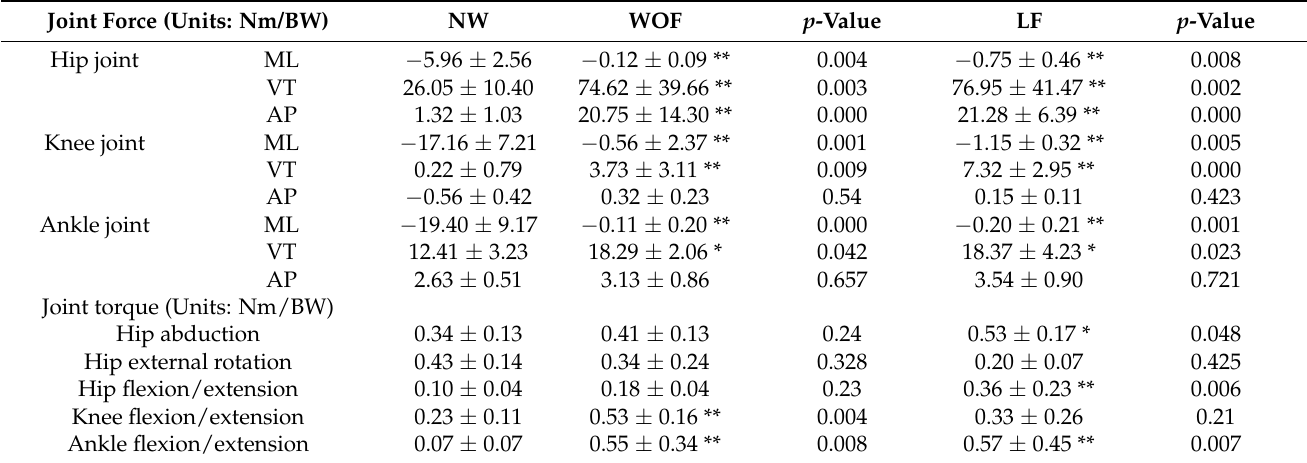
Table 3. Mean and standard deviation (mean ± SD) of the maximum joint force and joint torque of the hip, knee and ankle during the two progressive motions and